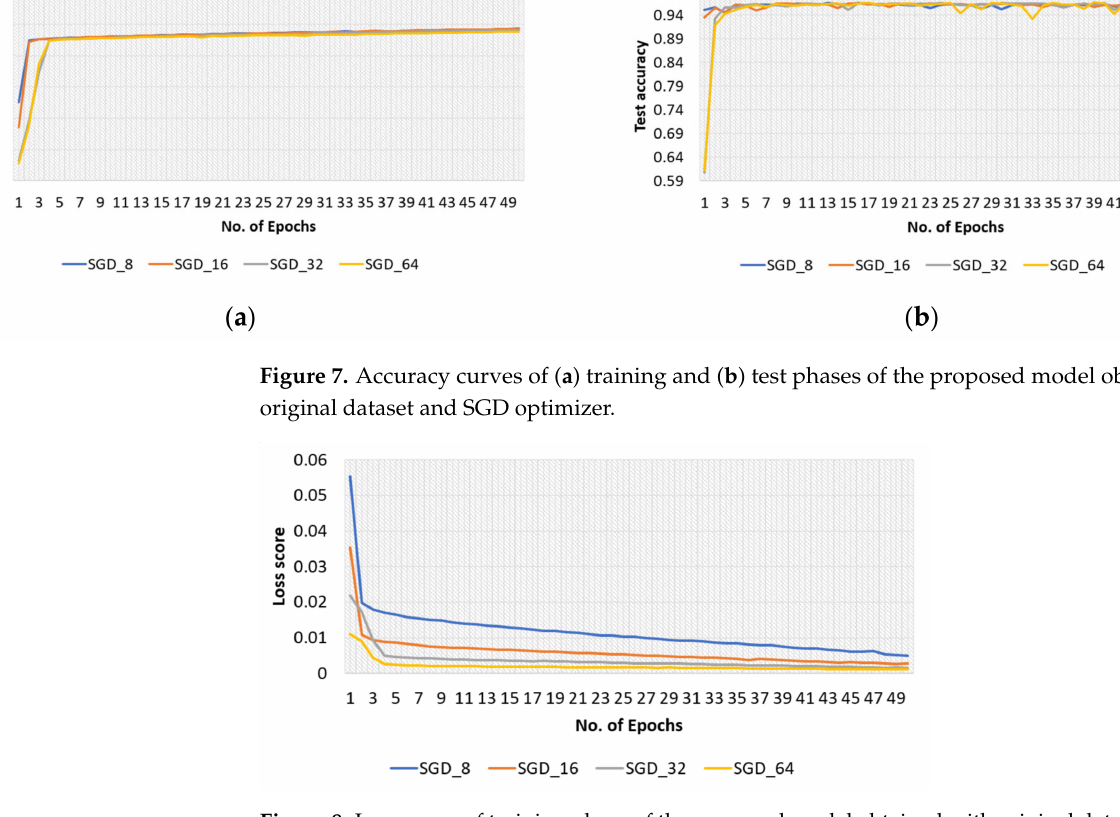
Figure 8. Loss curve of training phase of the proposed model obtained with original dataset and SGD optimizer.